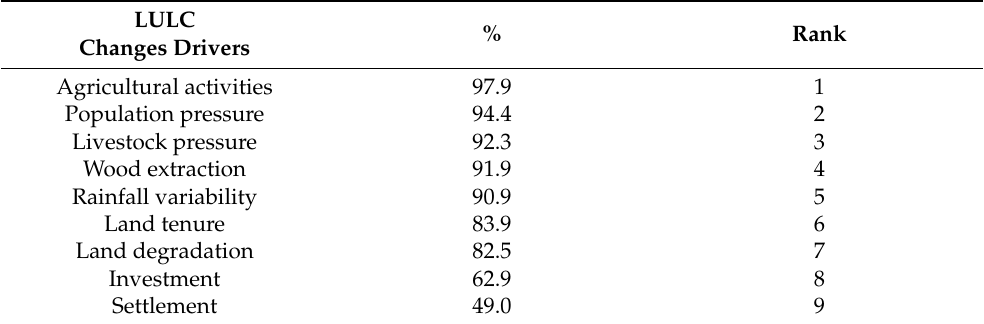
Table 9. The frequency of the major driving forces of LULC changes in the Matenchose watershed based on local farmers’ perceptions (N = 143).